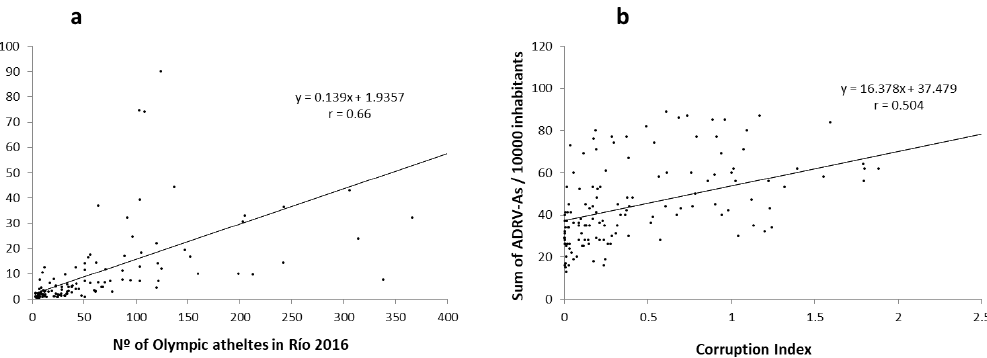
Figure 1. Relationship between ( a ) ADRV-As and the number of Olympic athletes taking part in Río 2016 Olympic Games of each country; ( b ) sum of ADRV-As and the Corruption Index of each country.